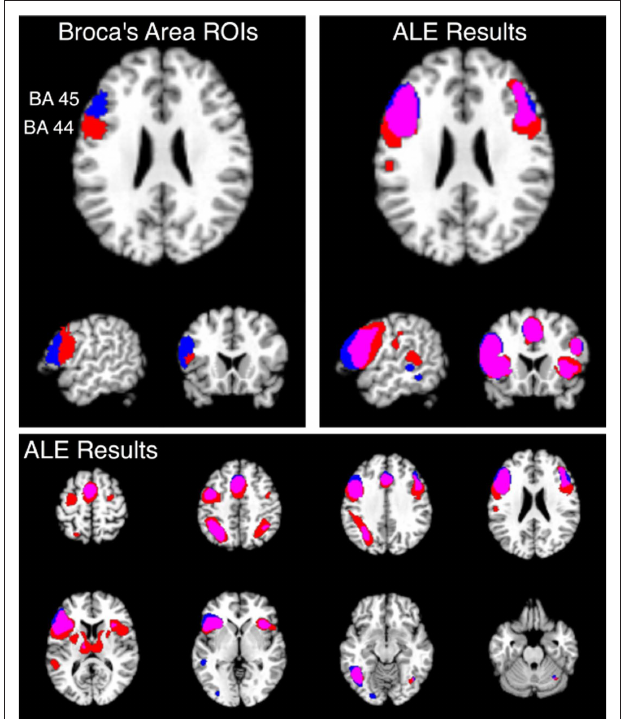
FIGURE 7 | Structure-based meta-analysis of Brodmann areas 44 and 45. ALE meta-analyses were performed for all experiments in BrainMap that reported activation in either BA 44 or BA 45 to determine the meta-analytic functional connectivity of these cytoarchitectonically-defi ned regions. Results are displayed at P < 0.05, corrected. The top slices (left and right) are centered at x = − 54, y = 18, z = 24. The upper left slices display the ROIs used to search BrainMap for BA 44 (red) and BA 45 (blue), which were obtained from the SPM Anatomy Toolbox (Eickhoff et al., 2005; Eickhoff et al., 2006b). ALE results for these regions are shown on the top right in axial, sagittal, and coronal slices, as well as on the bottom panel in axial slices from z = 58 to z = − 26. The overlap between meta-analyses for BA 44 and 45 is shown in